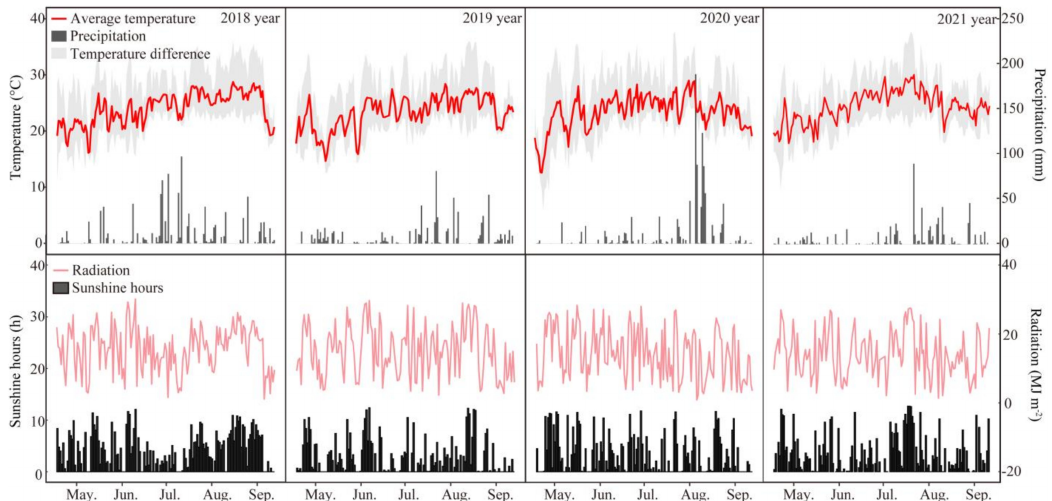
Figure 7. Meteorological data corresponding to the rice growth